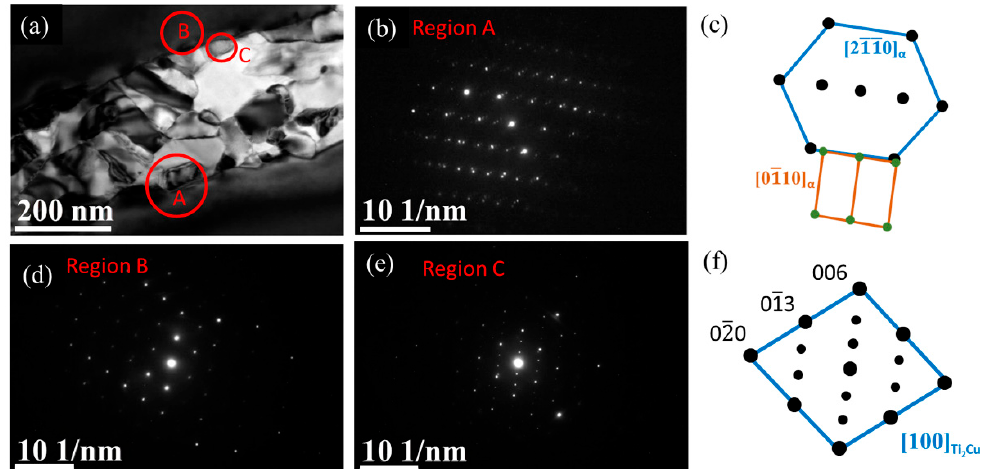
Figure 4. Transmission electron micrographs (TEM) were taken from the specimen annealed at 920 °C for 24 h. ( a ) Bright field (BF) image; ( b ) selected area diffraction pattern (SADP) of the matrix marked as A; the foil normal is [2110] ( c ) schematic diagram of SADP from ( b ); ( d ) SADP of the matrix marked as B, the foil normal is [1123]; ( e ) SADP of the matrix and precipitates marked as B, the foil normal is [100] Ti2Cu and ( f ) schematic diagram of SADP from ( c ).